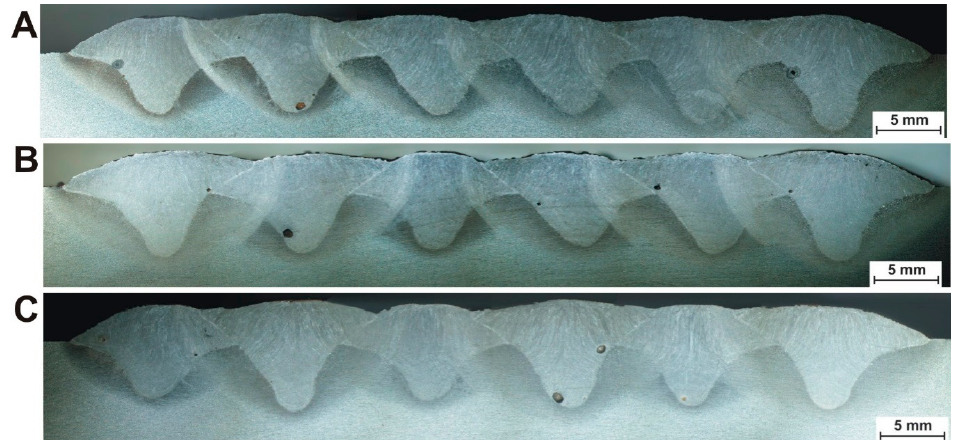
Figure 2. Macro-panoramas of the metallographic specimens in the middle cross-section of the plates.